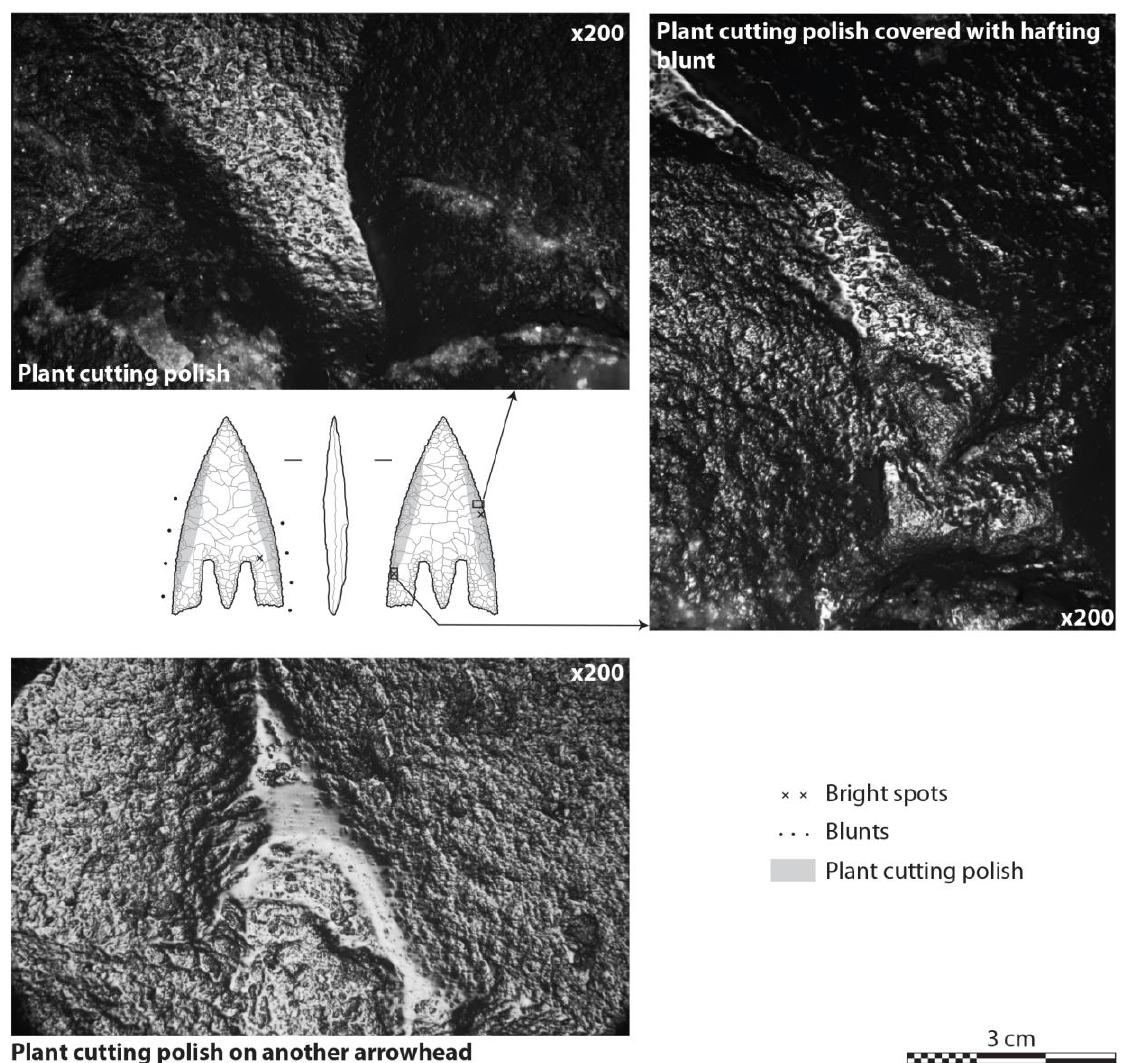
Figure 15. Plant cutting polish on arrowheads from Crec’h-Perros barrow, Perros-Guirec, Côtes-d’Armor (photo C. Guéret; drawing C.